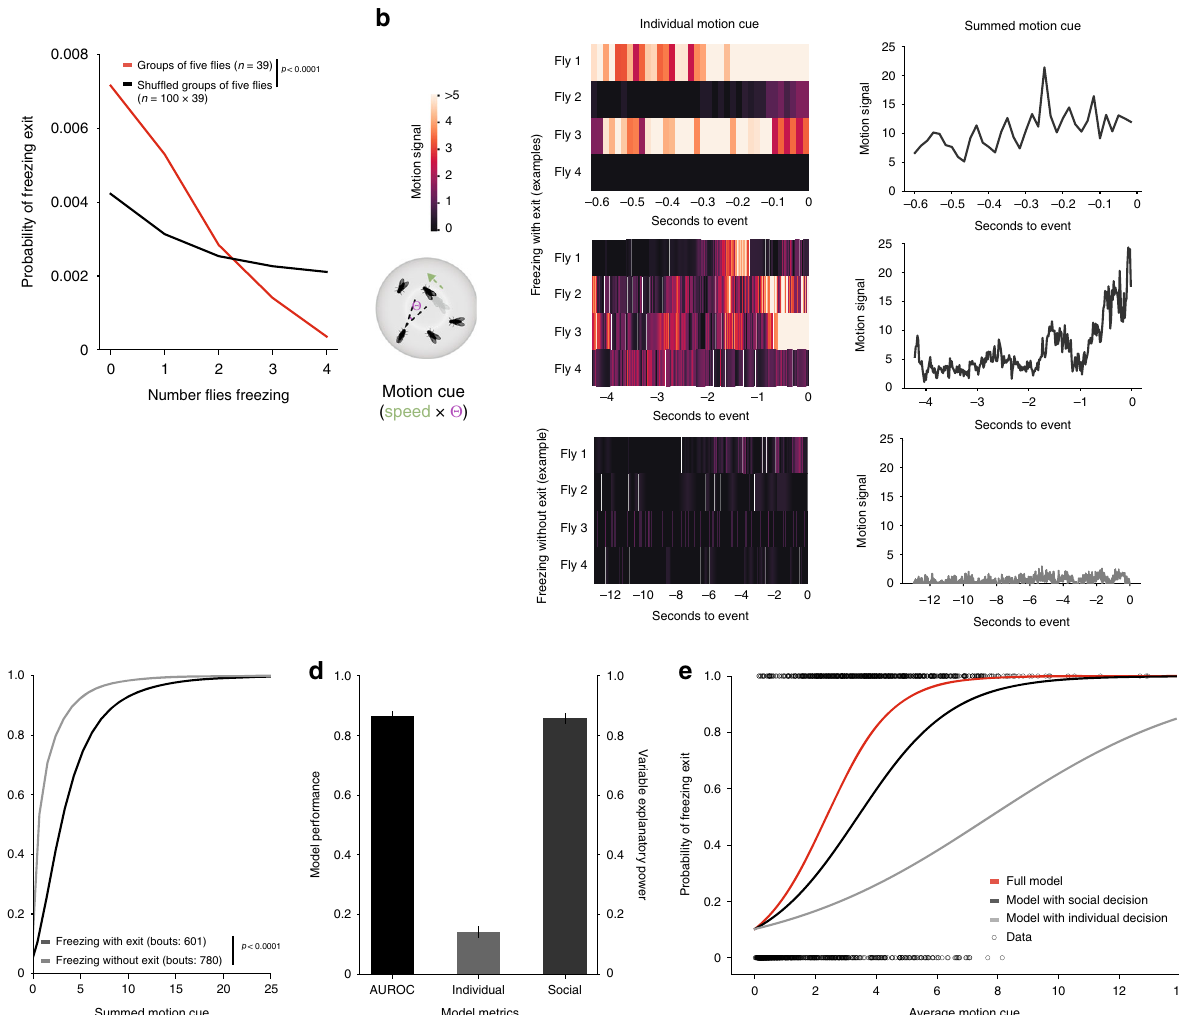
Fig. 3 The group effect on individual freezing exit. a Probability of freezing exit at time t as a function of the number of fl ies freezing at time t − 1 (see methods). P -value results from χ 2 contingency test (G-test). b The motion cue is formalized as the other fl y ’ s speed multiplied by the angle ( θ ) it produces on the retina of the focal fl y (schematic). Representative examples of the motion cue starting in the 500 ms bin after looming offset for a focal fl y until freezing exit or the end of the inter-looming interval (without freezing exit): heatmaps show the individual motion cues for each of the four surrounding fl ies and the line graphs show the summed motion cue of these four fl ies. c Cumulative distributions of the summed motion cues ( x axis cut at motion cue = 25). P -value results from Kolmogorov – Smirnov test. d , e Logistic regression model of the decision to stop or continue freezing as a function of individual and social decision processes (10,000 bootstrapping events). d Mean and standard deviation of model performance (AUROC – area under the receiver operating characteristic curve, black) and explanatory power of the individual (light gray) and social processes (dark gray). e Binary freezing data and average logistic predictive probabilities using individual and social coef fi cients alone or combined as a function of the average motion